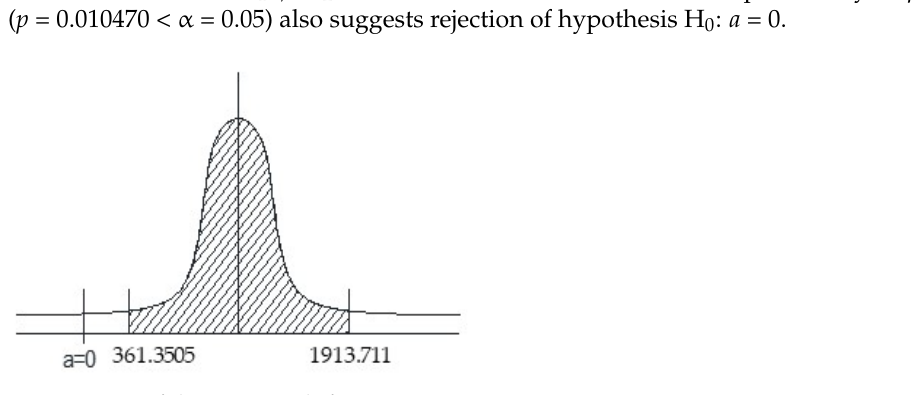
Figure 13. Confidence intervals for a . Table 5. Pillar parameters set for the elastic model using the Statistica v. 10 program.